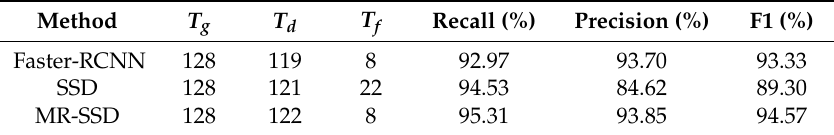
Table 8. Detection results of different CNN models on the large-scale SAR image.